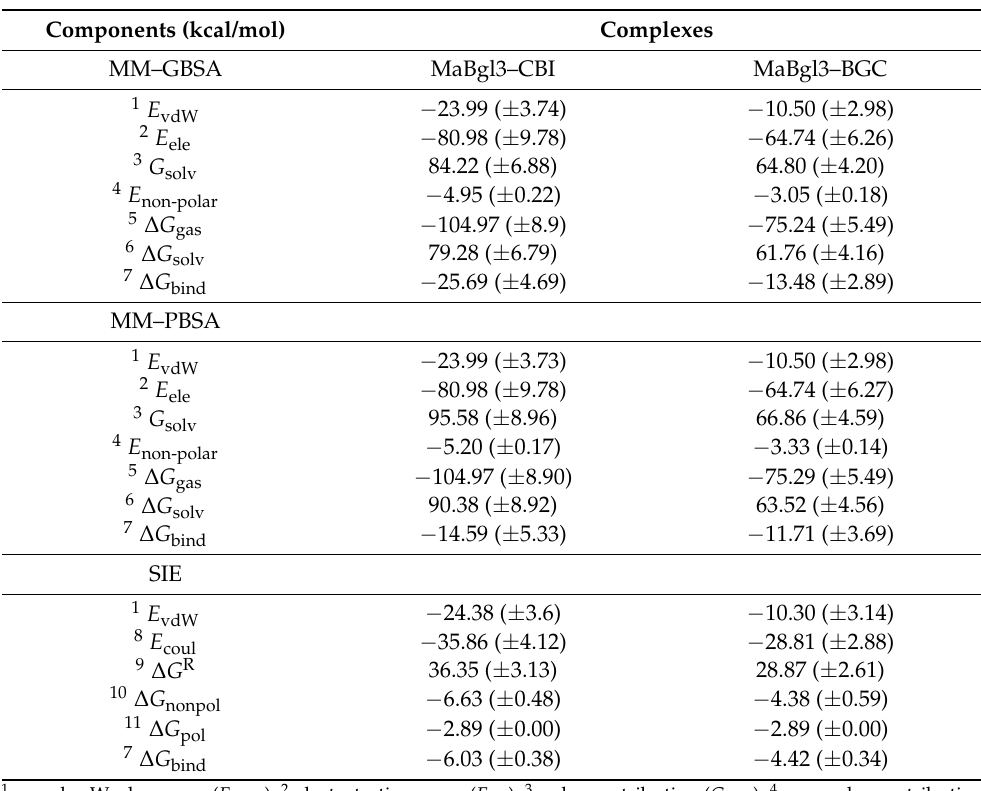
Table 6. Binding free energy and its components are calculated using the MM–GBSA, MM–PBSA, and SIE methods for the MaBgl3–CBI and MaBgl3–BGC complexes. All values are reported in kcal/mol. (Continues).